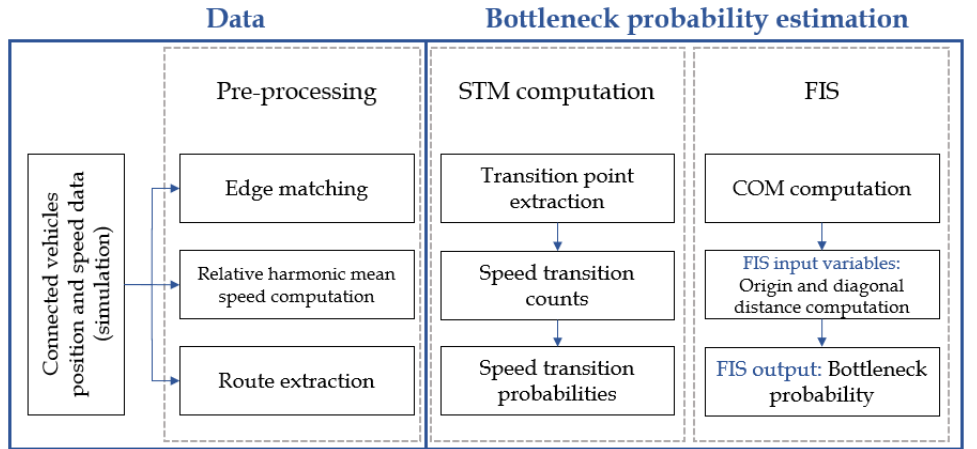
Figure 2. Overview of the methodology for the bottleneck probability estimation.